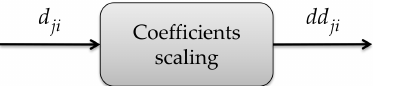
Figure 7. Detail coefficient scaling submodule.